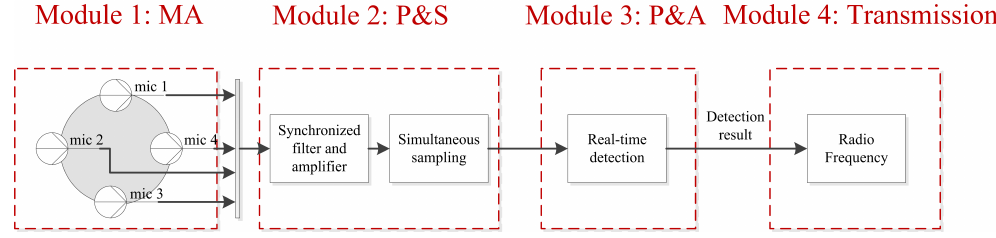
Figure 1. The diagram of the system hardware